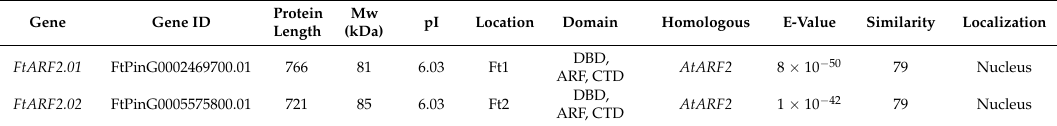
Figure 4. Expression analysis of the two FtARF2 genes in the different accessions of Tartary buckwheat fruits at 13 and 19 DAP. ( A ) Expression analysis of the two FtARF2 genes in STB fruit at 13 and 19 DAP. ( B ) Expression analysis of the two FtARF2 genes in BTB fruit at 13 and 19 DAP. ( C ) Expression analysis of the two FtARF2 genes in the different accessions of Tartary buckwheat fruits at 13 DAP. ( D ) Expression analysis of the two FtARF2 genes in the different accessions of Tartary buckwheat fruits at 19 DAP. * and ** indicate significant differences at 0.05 and 0.01 levels, respectively. Table 2. FtARF2 genes encoding ARF proteins along with their molecular